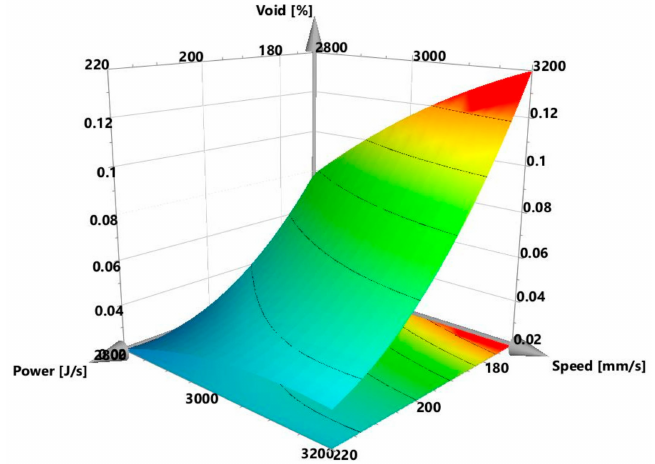
Figure 6. Response surface plot showing void content at di ff erent powers and speeds for a hatch of 30 µ m.